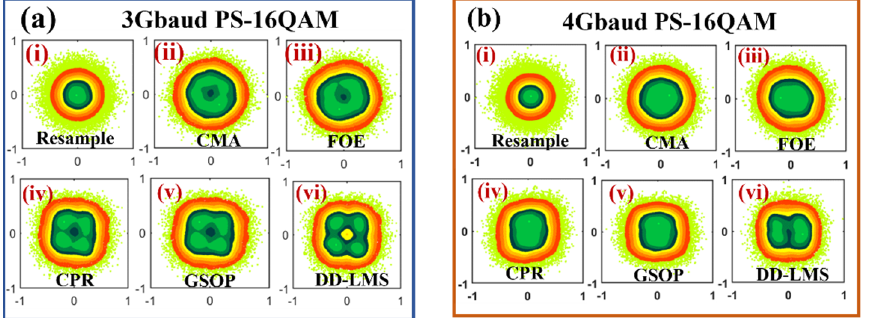
Figure 5. The density distribution of constellation diagrams for ( a ) 3Gbaud PS-16QAM and ( b ) 4Gbaud PS-16QAM, respectively, after (i) resample; (ii) CMA; (iii) FOE; (iv) CPR; (v) GSOP, and (vi) DD-LMS. Green: High Density, Orange Yellow: Regular Density, Bright Yellow: Sparse Density.